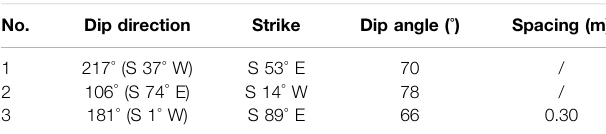
TABLE 1 | Major discontinuities in the hanging